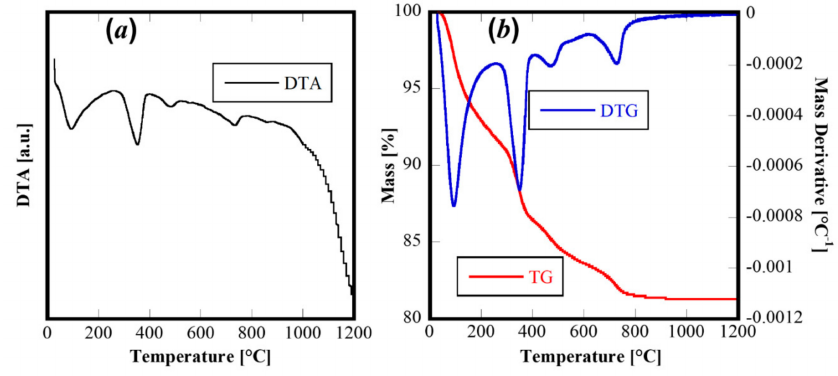
Figure 3. DTA ( a ) and TG / DTG ( b ) of sample